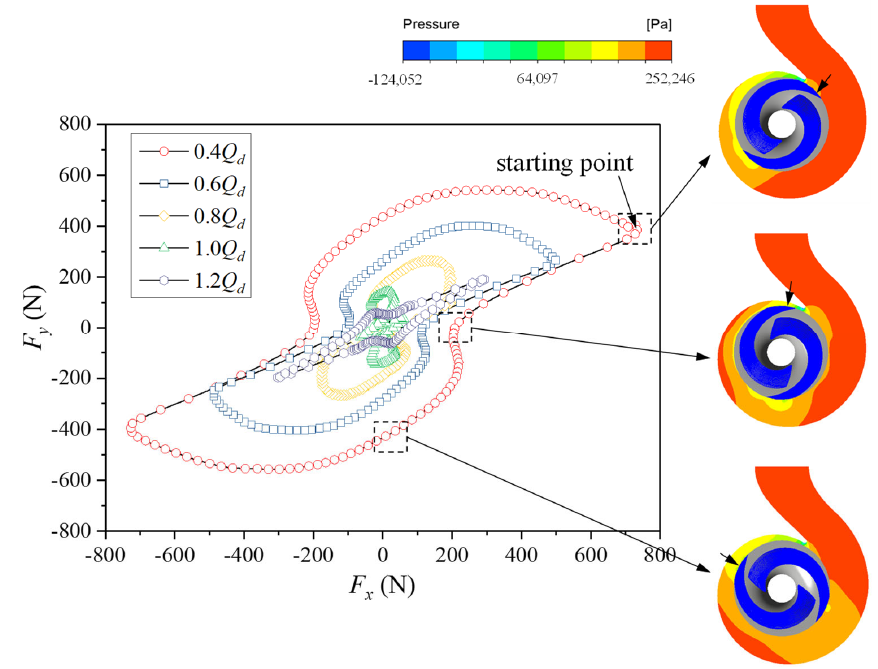
Figure 15. Radial force of blade at different flow rates.